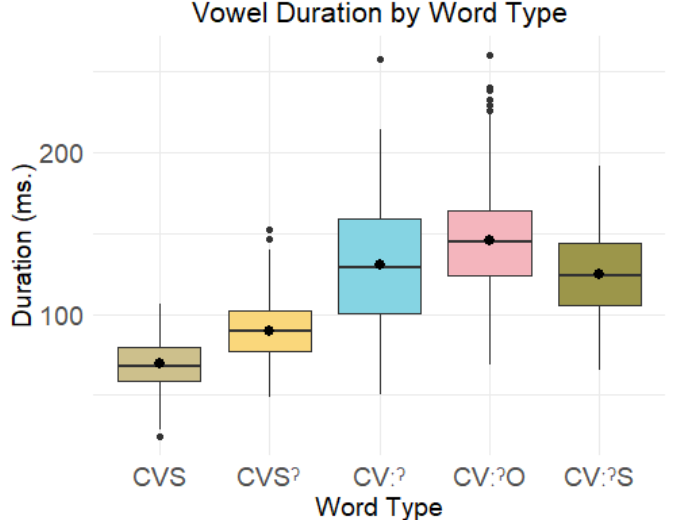
Figure 10. Vowel duration in milliseconds by word type. All differences are significant except the comparisons between CV ːˀ and CV ːˀ O words and between CV ːˀ and CV ːˀ S words. Black dots indicate the mean vowel duration per word type.